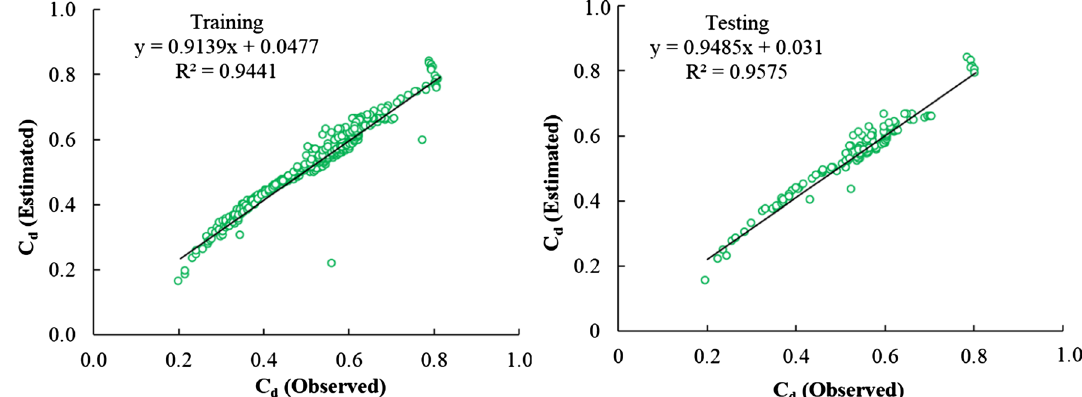
Fig. 5 Distribution diagram of the observational estimated values of the training and testing stage of SVM-RBF